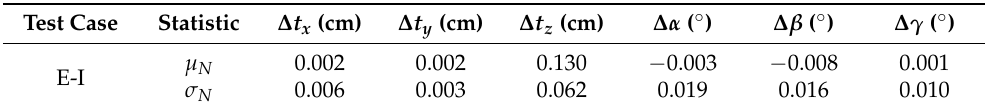
Table 18. Mean and standard deviation of the pose estimation errors for different levels of uncertainty in the knowledge of the initial condition, for test case E-I.